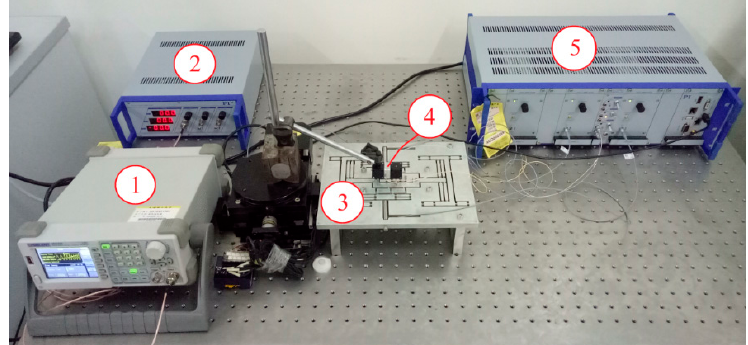
Figure 23. Natural frequency detection system. ( 1 ) signal generator; ( 2 ) power amplifier; ( 3 ) three-dimensional (3D) motion device; ( 4 ) capacitance sensor; ( 5 ) capacitance detection channel.